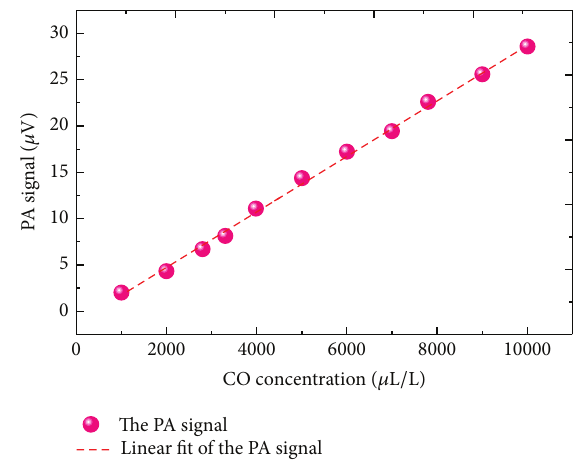
Figure 10: The regression relationship between CO concentration and PA signal with the least square regression